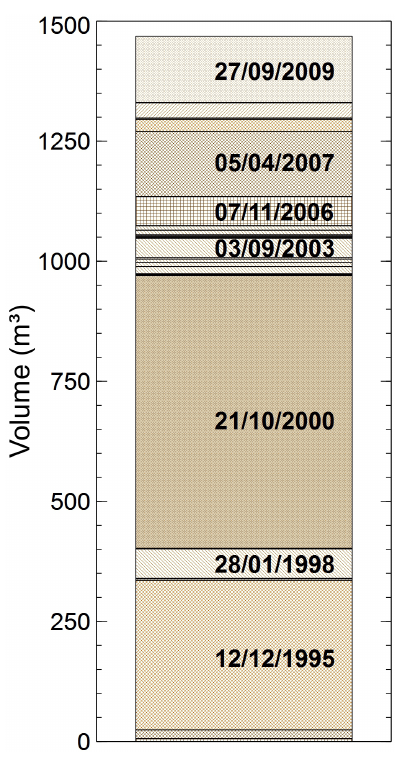
Fig. 10. Reconstruction of deposited volumes with indication of the flood dates (dd/mm/yyyy). The six larger modelled events were as- signed to a single or multiple stratigraphic units (numbers preceding the flood date) whose numbers are indicated in Fig. 9. The last three events were assigned to the surface gravel